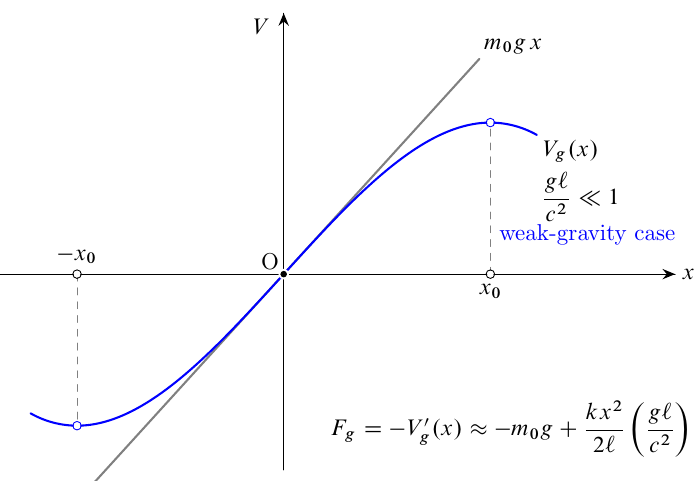
Figure 1. In the weak gravity case, when g (cid:96) / c 2 (cid:28) 1, the approximation for the relativistic gravita- tional potential V g in the non-relativistic limit is most suitable (blue curve), see Equation (16). This approximate result is symmetric with respect to rotations of 180 ◦ about the origin—a symmetry property which is lost in the full relativistic case. The approximate model is only physically valid (cid:113) 2 m 0 c , so that sign-flips of the force field are avoided. well within the interval [ − x 0 , x 0 ] , where x 0 = k The non-relativistic, classical case is indicated by the straight gray